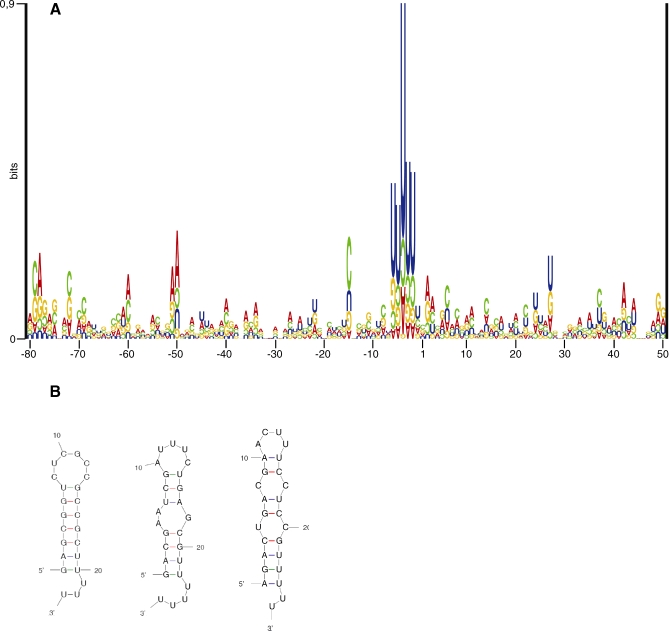
Transcription Termination in Halophilic Archaea(A) The sequences from −80 to +50 around the experimentally determined 3′-ends of haloarchaeal transcripts (Tables 1 and 2) were retrieved from databases. A sequence logo was constructed with the program “RNA structure logo” [29].(B) Three typical examples of secondary structures predicted to be formed at the 3′-end of transcripts. Note that the oligo-U motif is partially involved in basepairing in the stemloop in all three cases. From left to right, the examples show the 3′-ends of the transcripts of the genes numbers 4, 15, and 16 in Table 2.